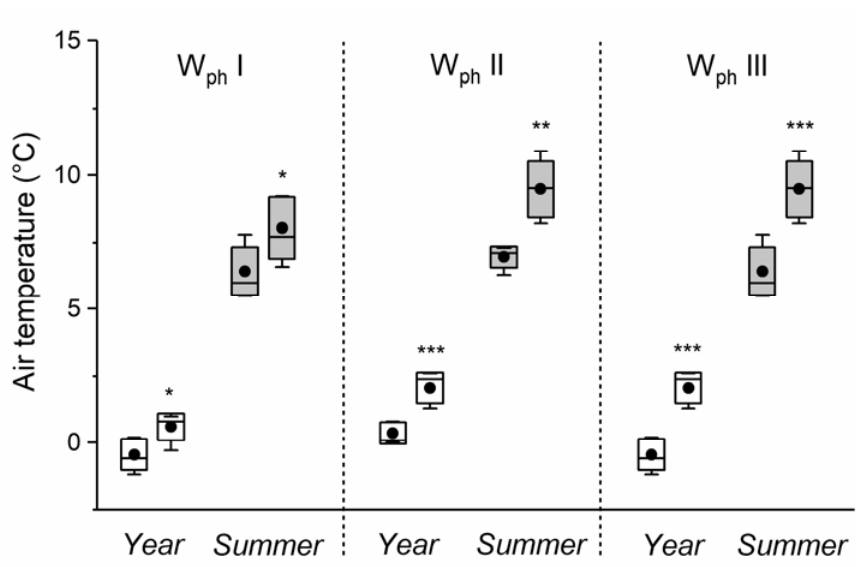
Figure 2. Comparison of yearly and summer (June–August) air temperatures between the beginning and end of phase I (W ph I), phase II (W ph II), and during the whole study period, i.e., beginning of phase I and end of phase II (W ph III; cf. Figure 1). A box and whiskers plot shows the median (horizontal line) and mean values (closed circle) ± standard deviation (box); whiskers extend to the 10th and 90th percentiles. Statistical significant differences between mean temperatures at the beginning and end of the warming phases are indicated by asterisks (* p ≤ 0.05, ** p ≤ 0.01, *** p ≤ 0.001). Comparing the first (1915–1919) and last (2011–2015) five-year mean values, yearly and summer ◦ ◦ air temperature increased by + 2.5 C and + 3.1 C, respectively (Figure 3). In contrast, yearly and summer precipitation showed a slight but statistically not significant increase ( p > 0.05) over the whole study period (Figure 1c).